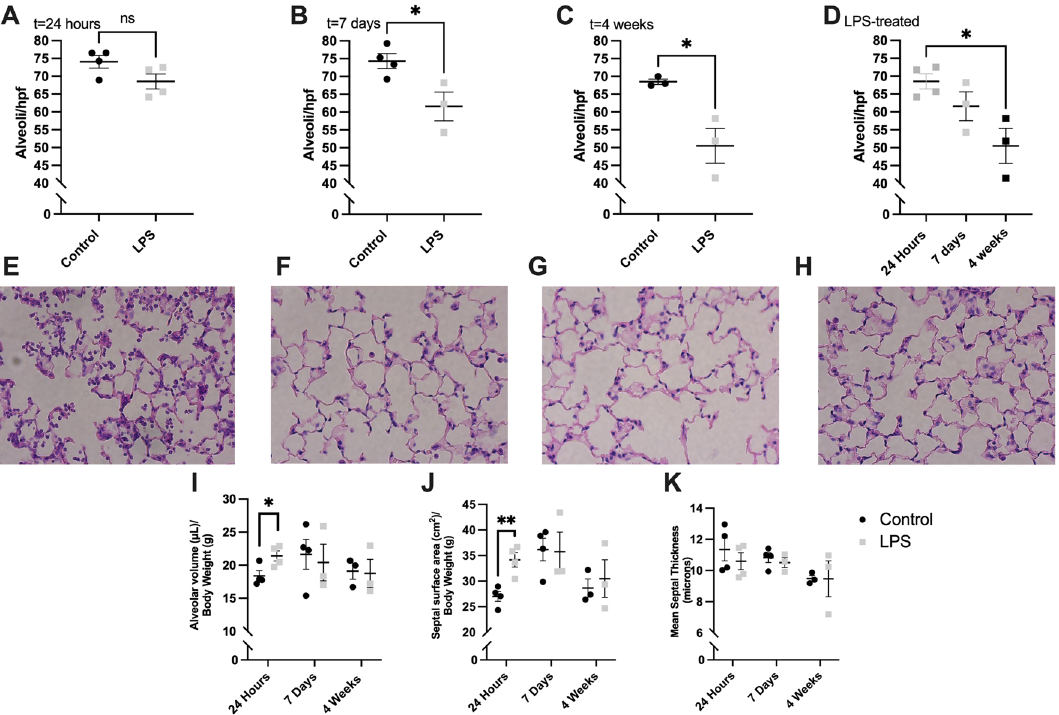
Figure 3. Lung tissue morphometric analysis. Lipopolysaccharide (LPS)-treated mice had similar number of alveoli to controls at 24 h following instillation ( A ). However, LPS-treated mice exhibited a progressive decrease in alveolar counts compared to control mice at 7 days ( B ) and 4 weeks ( C ) after instillation. The lungs of LPS- treated mice at 4 weeks had significantly lower number of alveoli compared to the lungs of LPS-treated mice at 24 h ( D ). Representative micrographs of hematoxylin and eosin-stained lung sections at 400 × magnification demonstrate progressive alveolar simplification in LPS-treated mice from 24 h following instillation ( E ), to 7 days ( F ), and 4 weeks ( G ). Representative micrograph of control lungs at 24 h is provided for reference ( H ). Alveolar volume ( I) and septal surface area ( J ) were significantly higher in LPS-treated mice compared to controls at 24 h but there were no significant differences at 7 days and 4 weeks. There were no significant differences in mean septal thickness ( K ) at the various time points. Alveolar counts were determined by two independent masked reviewers and averaged. Statistical analysis of the experimental groups at each time point was performed with Student’s t-test. Comparison of the alveolar counts in LPS mice was done using a one-way analysis of variance (ANOVA) with Tukey’s adjustment for multiple comparisons. Results are expressed as mean ± SE. hpf: high power field; ns: nonsignificant; * P < 0.05; ** P <